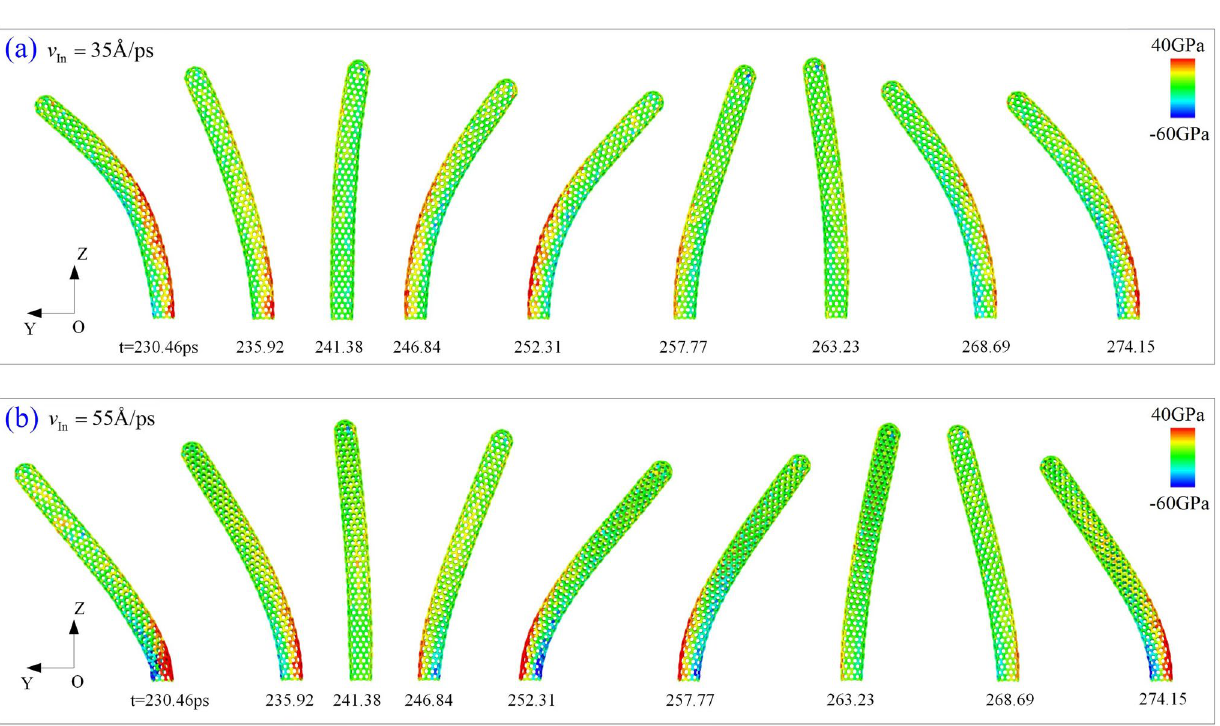
Figure 3. Snapshots in the first period of vibration of the nanobeam after colliding with C 60 . When incident velocity is ( a ) 35 /ps, and ( b ) 55 Å Å